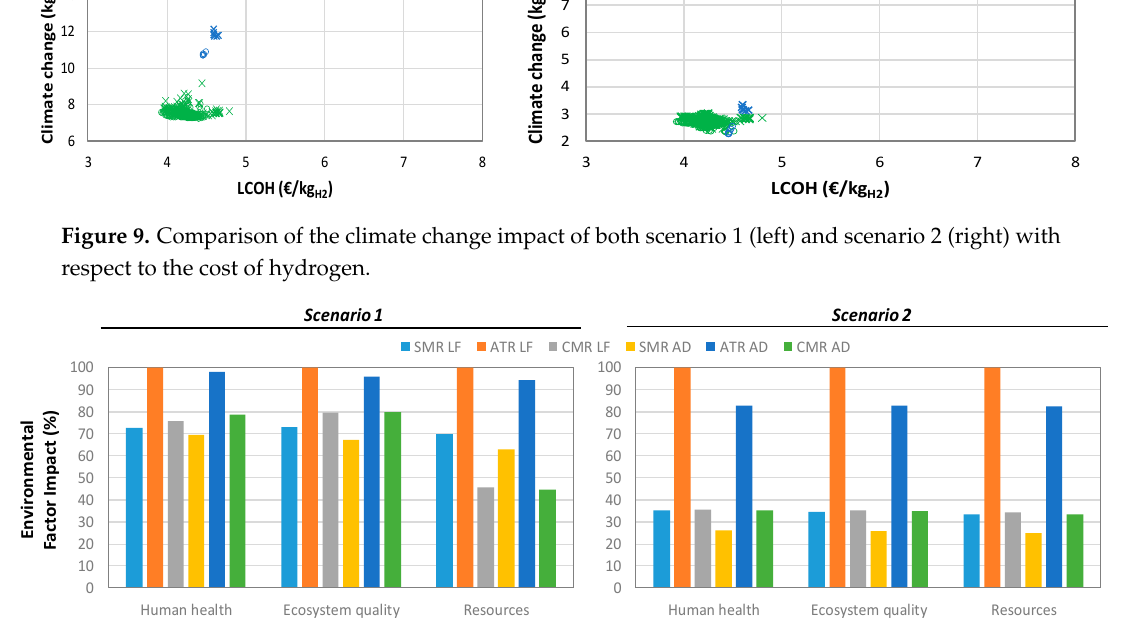
Figure 10. Comparison of endpoint environmental impact of different systems under different scenarios.